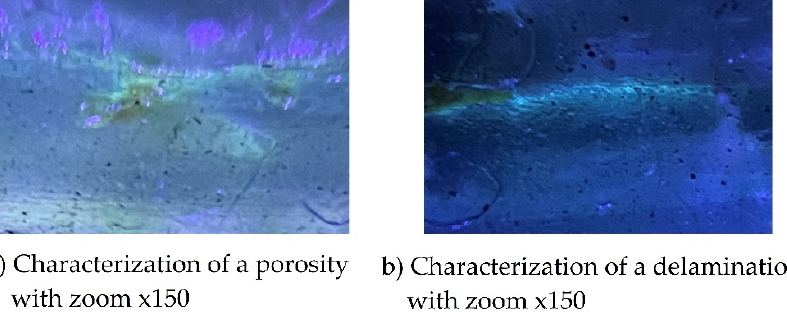
Figure 11. Characterization with ultraviolet light to a section impacted with 20 Joules with ( a ) porosity viewed at × 150 zoom, ( b ) delamination at × 150 zoom.